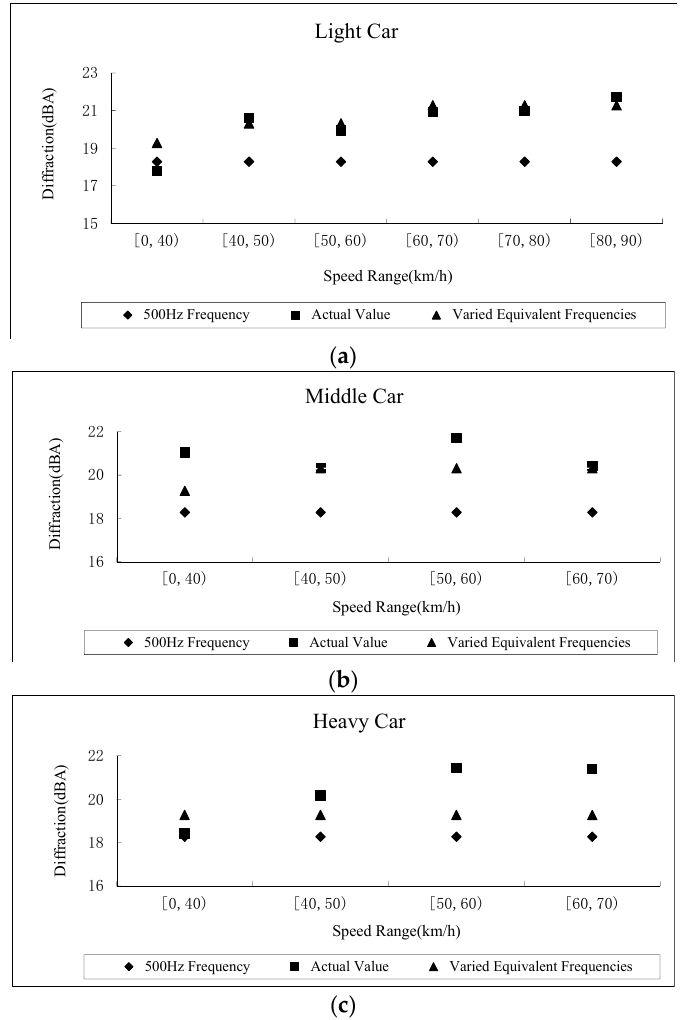
Figure 5. Comparisons between 500 Hz frequency and the variety of equivalent frequencies for diffraction by barrier. ( a ) light vehicle; ( b ) middle vehicle; ( c ) heavy vehicle.